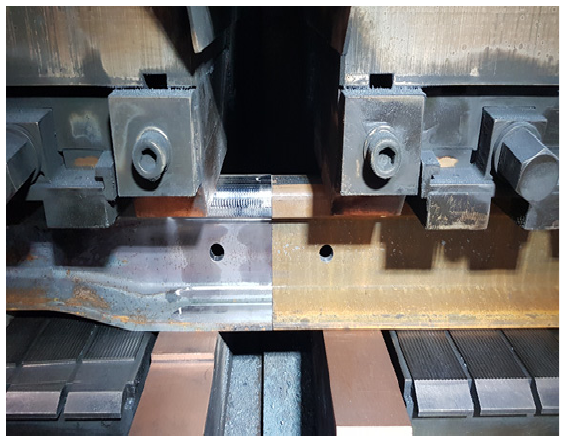
Figure 4. Welding method of rail joints: butt positioning of rail ends in the welder. Source: own.